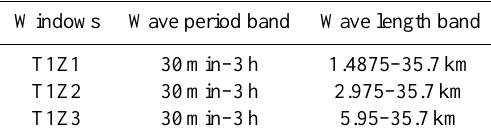
Table 1. Wave periods bands and wave length bands corresponding to the frequency- and wave number-windows used to sample the wave packets for phase and group velocity tracing